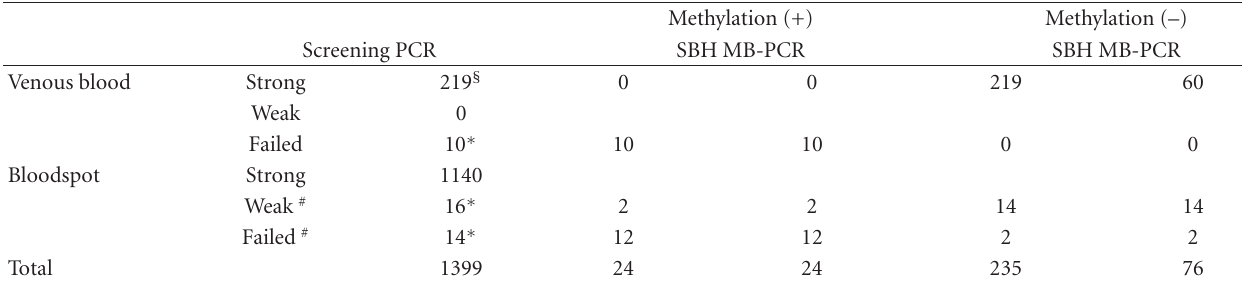
Table 1: Molecular testing of 1399 males suspected of having fragile X